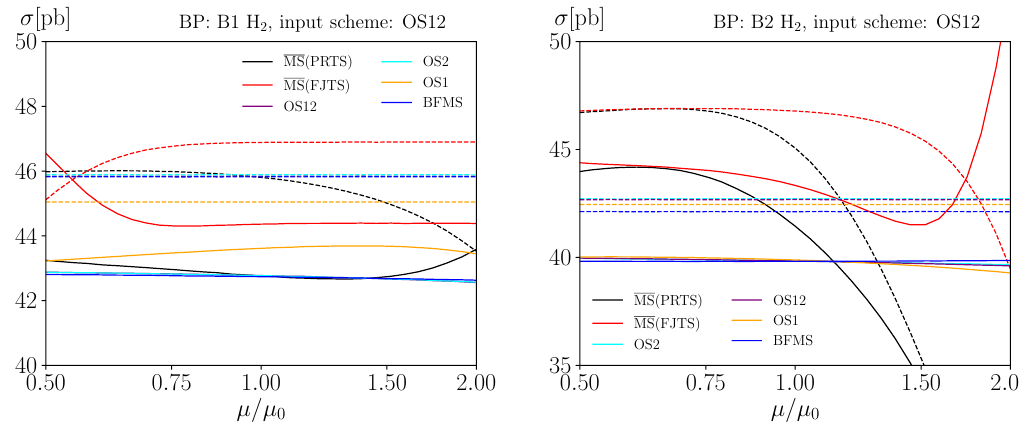
Figure 6 . Scale dependence for light-Higgs-boson production in Higgs-strahlung, pp X , for the THDM benchmark scenarios B1 (left) and B2 (right) in di(cid:11)erent renormalization schemes, with the OS12 scheme as input scheme (and full conversion of the input parameters into the other schemes). LO results are shown as dashed, NLO as full lines; the central scale is set to (cid:22) 0 = ( M H + M H + M A + 2 M ) = 5. H + 2 1 0